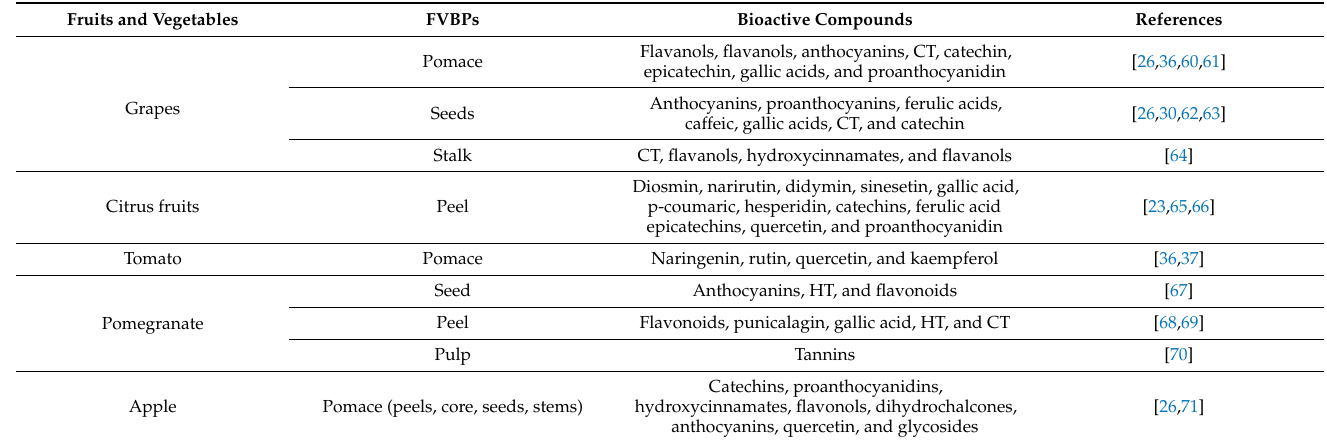
Table 2. Bioactive compounds (polyphenols) in FVBPs used in ruminant